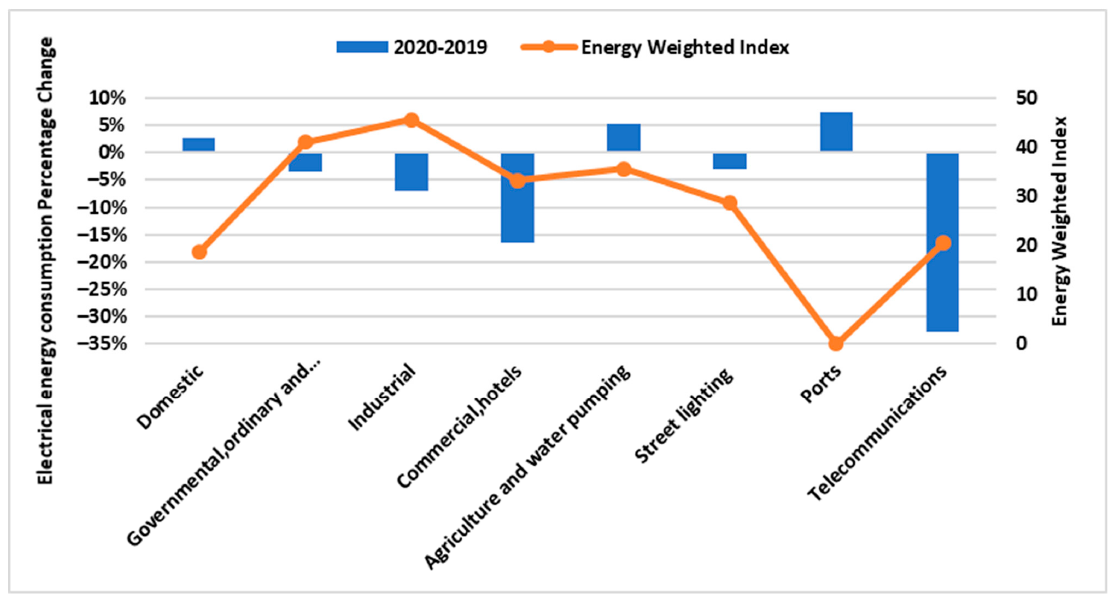
Figure 20. Change in electricity consumption at EDCO’s region between 2019 and 2020 for the dif- ferent sectors with EWSX.